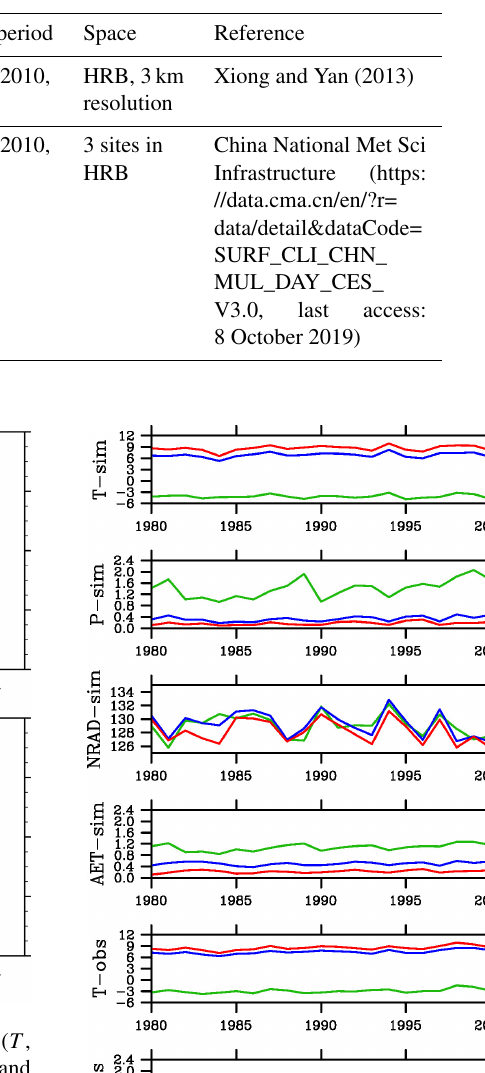
Table 1. The data used in calculation and evaluation of the aridity indices. H , AET, P , T , and e (RH) are sensible heat flux, actual evapo- transpiration, precipitation, temperature, wind speed, and water vapor pressure (relative humidity). HRB stands for Heihe River Basin.